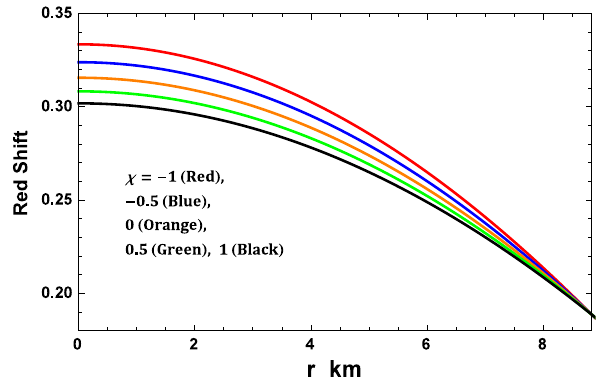
Fig. 6 Red-shift profiles of SMC X-4 for M = 1 . 29 M (cid:9) , R = 8 . 831 km and b = 0 . 0031km − 2